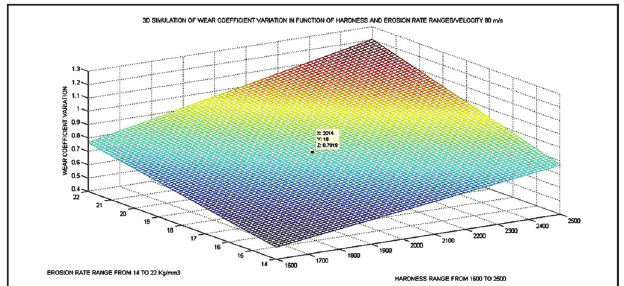
Fig. 7. 3D surfactal simulation results for Table IV and Eq. (2) model. The impact velocity is 80 m/s. Results are acceptable with a Global Minimum sharply determined by cursor, 0.7919, which verifies the optimization goodness software results. Matrices of imaging are 75 × 75 – with Matlab it is possible to reach 1000 × 1000 dimensions, with Freemat the maximum size is nearby 400 × 400 for acceptable running image-performance time.